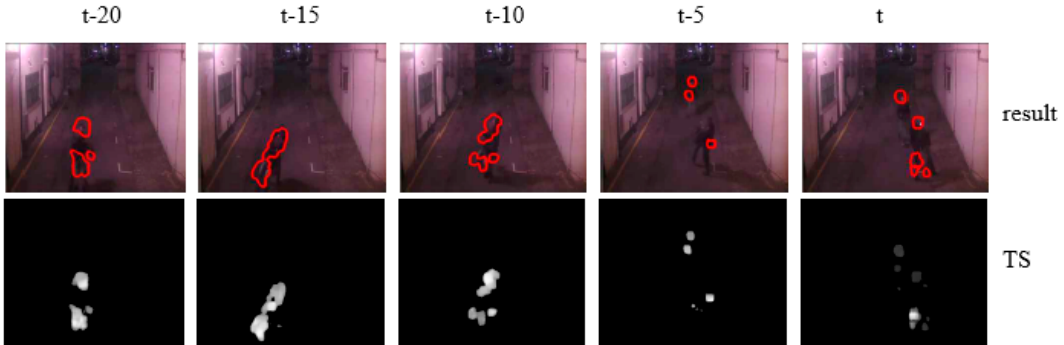
Figure 17. Examples of detection results for abnormality from the No. 10 data.